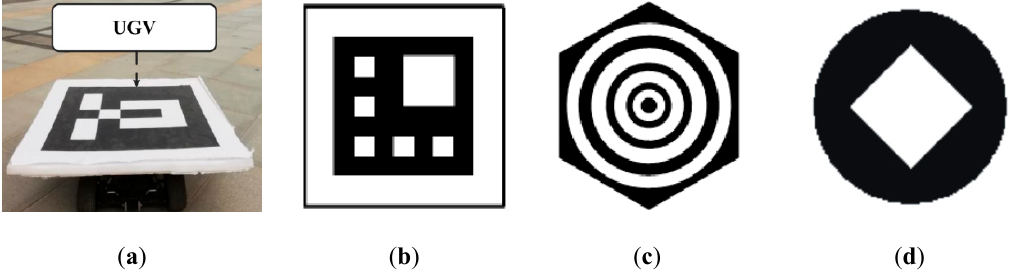
Figure 11. Cooperative targets of UAV autonomous landing based on Visual Navigation in related literatures. ( a ) T. Yang [74]; ( b ) J. Li [78]; ( c ) Sharp. S. [79]; ( d ) L. Sven [80].